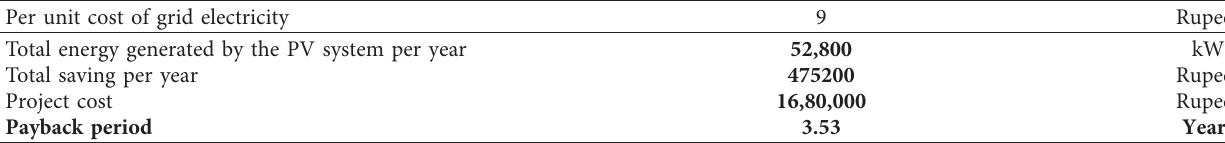
Table 13: PV system cost savings and payback calculation.